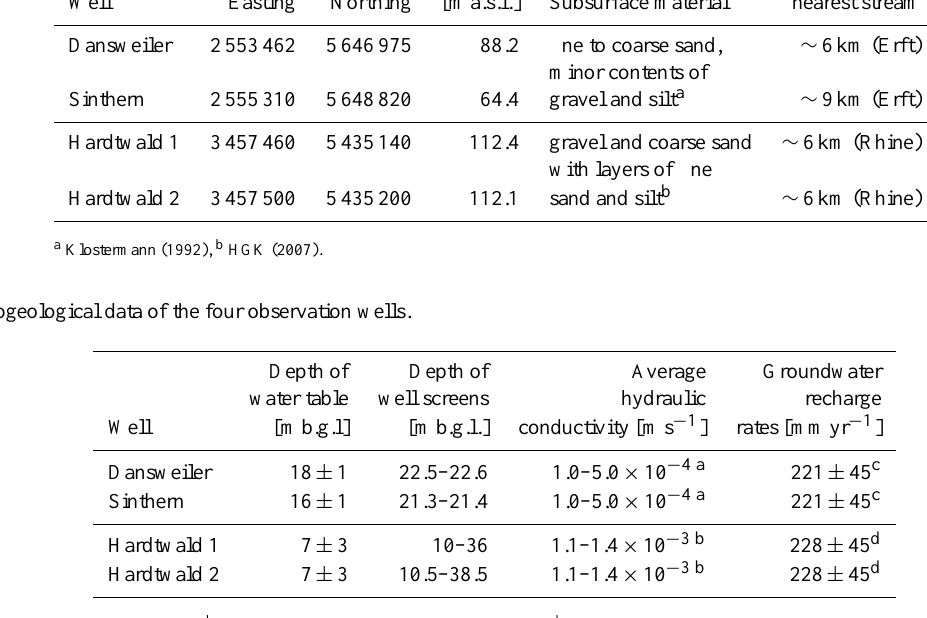
Table 1. Location coordinates of the observation wells with basic information about the hydrological setting. Altitude Distance to Well Easting Northing [ma.s.l.] Subsurface material nearest stream Dansweiler 2553462 5646975 88.2 fine to coarse sand, minor contents of Sinthern 2555310 64.4 gravel and silt a